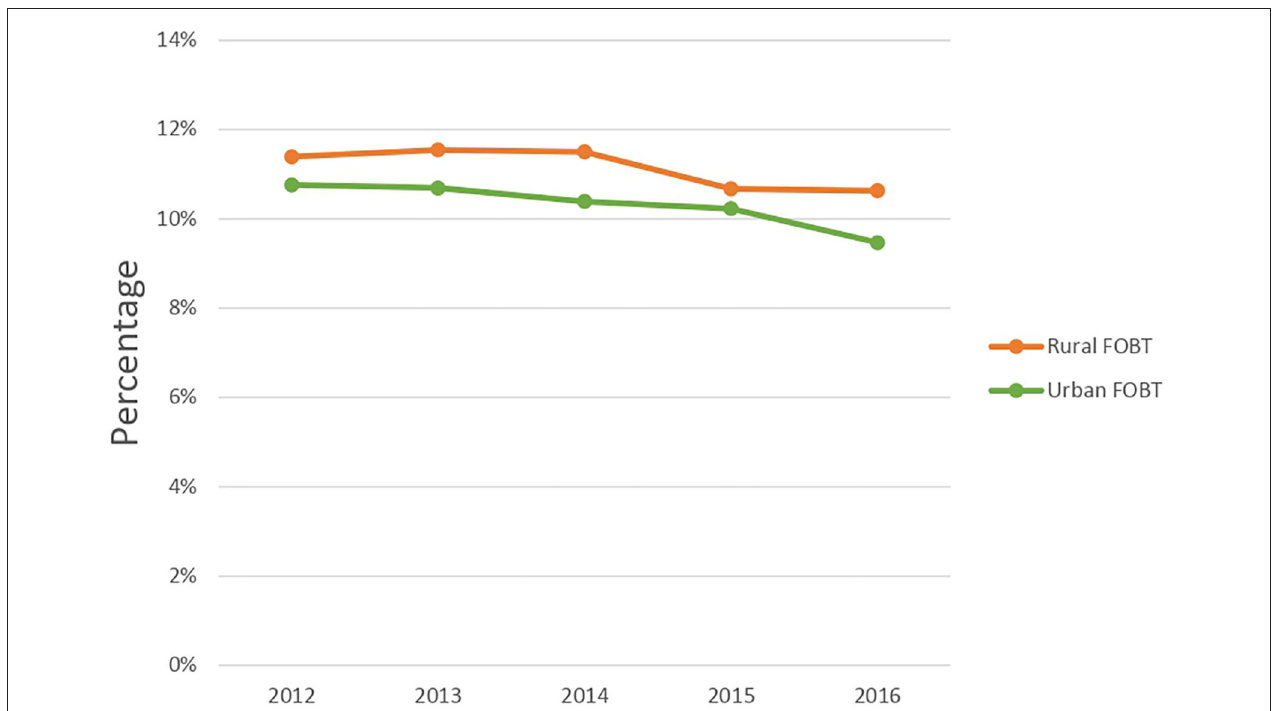
FIGURE 2 | Annual fecal occult blood test in Blue Cross Blue Shield Nebraska population, 2012–2016.